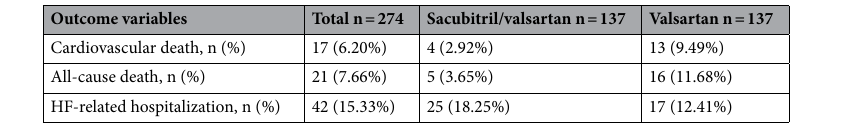
Table 5. Mortality and HF-related hospitalization of the cohort. HF heart failure.